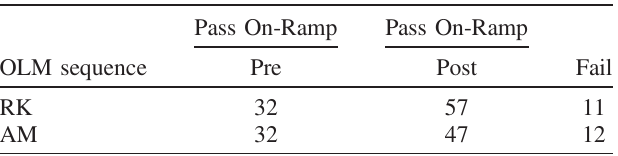
TABLE III. The number of students in each OLM sequence that fall into each on-ramp cohort among those with 0 – 1 brief attempts. The cohorts consist of those who passed during on- ramp Pre-study attempts ( “ Pass On-Ramp Pre ” ), those who passed during on-ramp Post-study attempts ( “ Pass On-Ramp Post ” ), and those that failed the on-ramp assessment ( “ Fail ” ). Since the on-ramp module was only included in Fall 2018, only students from 2018 are included